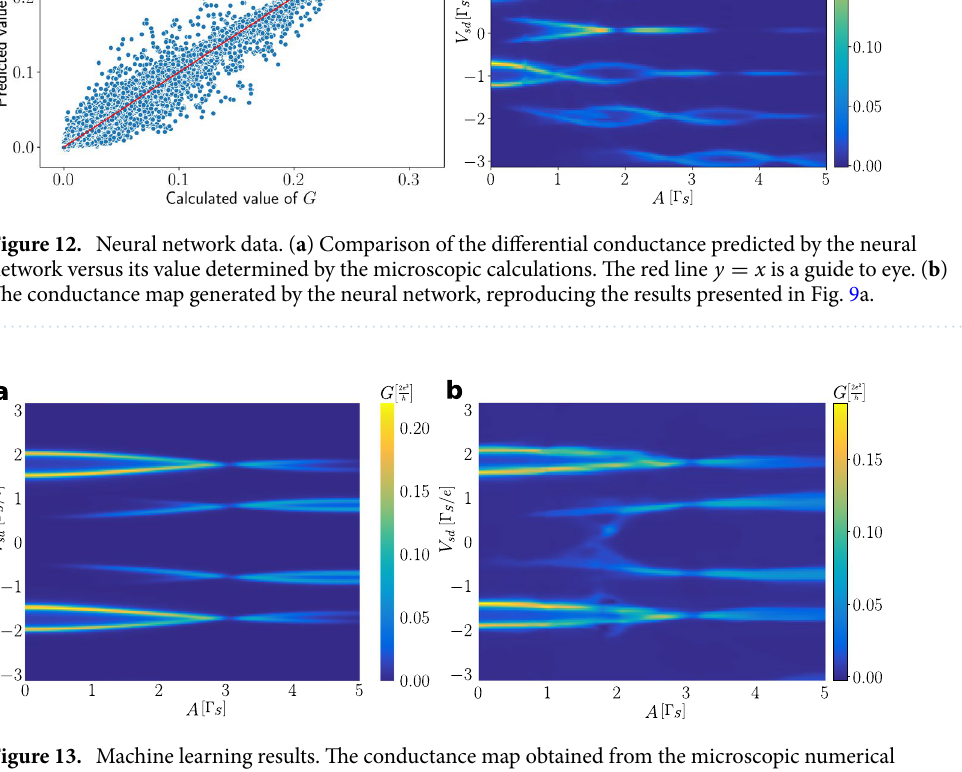
2.5 . The map shown in panel a has 1.7 , ω = =